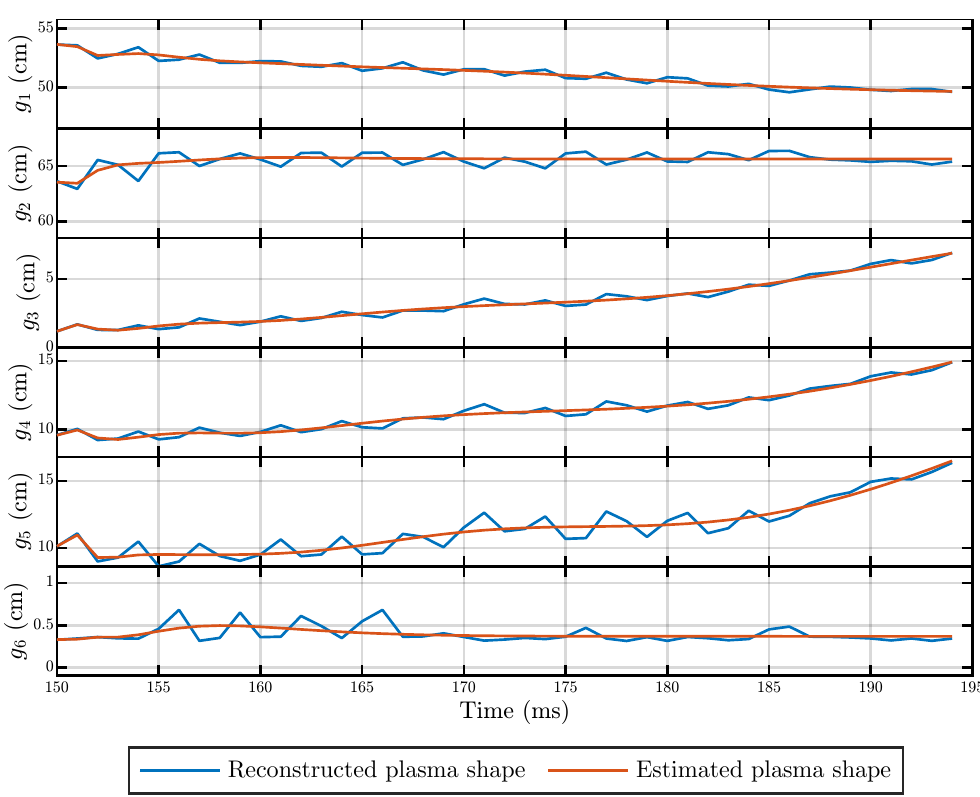
Figure 12. Neural network estimation of the gap values. Discharge #37270 of the Globus-M2 spherical